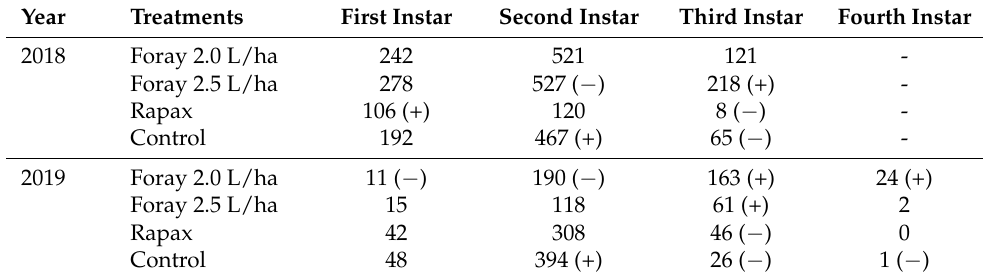
Table 1. Occurrences of Lymantria dispar larval instars observed in 2018 and 2019 in untreated (control) areas and areas treated with Foray ® 76B AVIO and Rapax ® AS AIR 2018 in Sardinia (Italy). Pearson standardized residuals measuring the deviation from expected values are reported in brackets (+ = positive deviation; − = negative